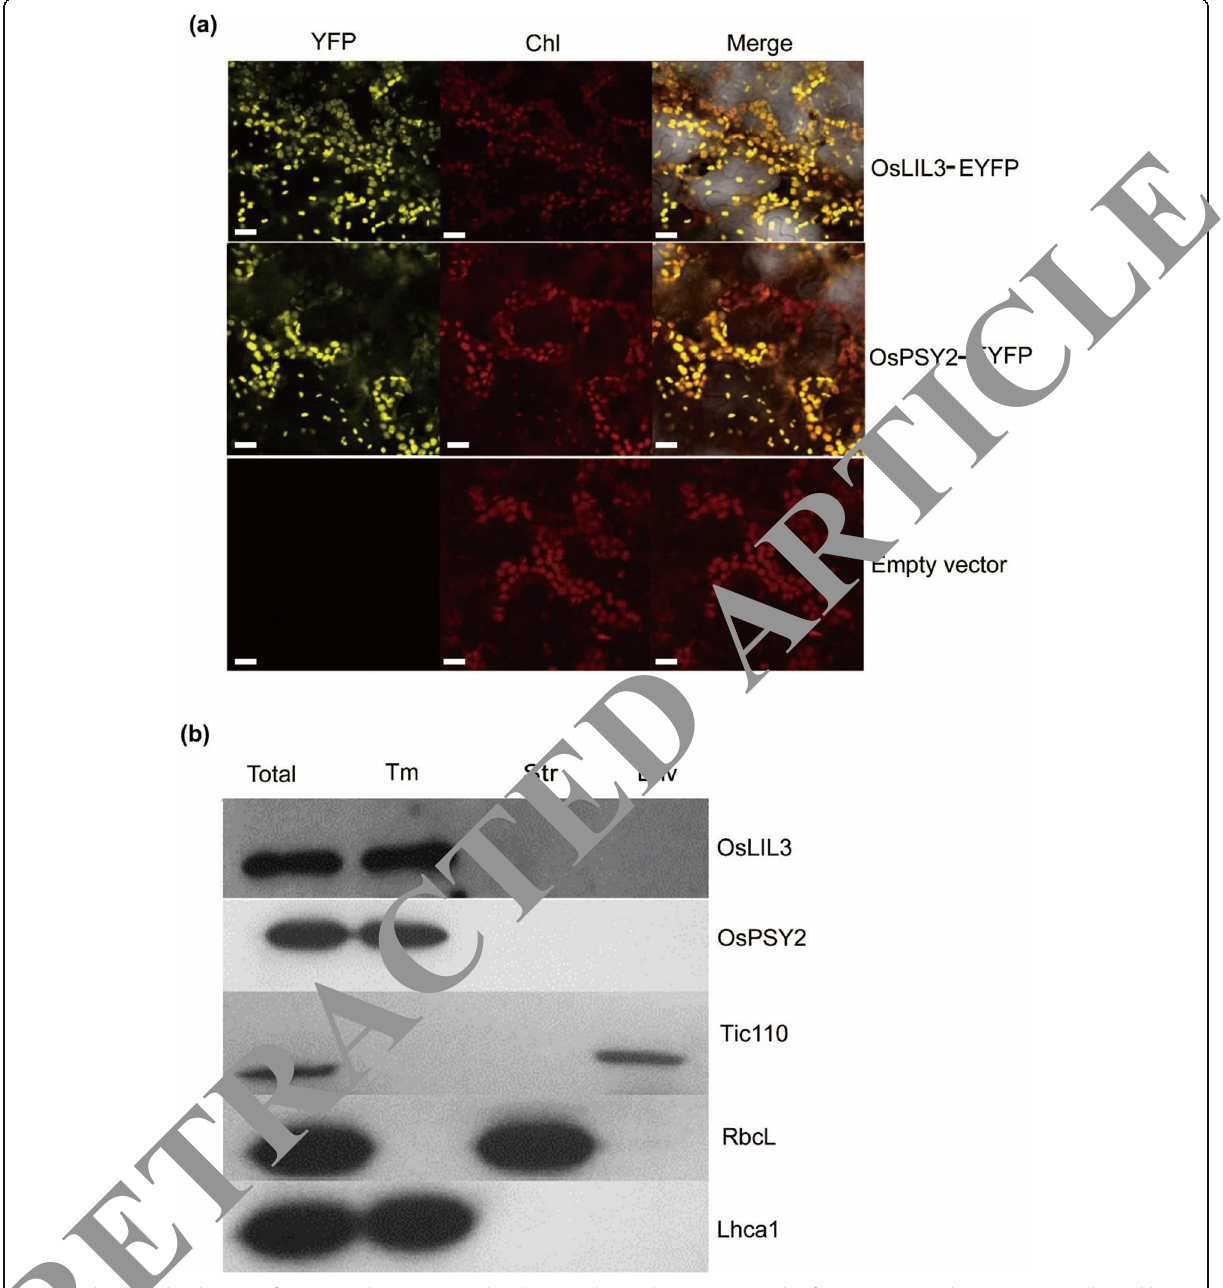
Fig. 5 Subcellular localization of OsLIL3 and OsPSY2 in N . benthamiana leavesFluorescent signals of OsLIL3-EYFP and OsPSY2-EYFP indicated by confocal microscopy. In both cases, chlorophyll autofluorescence (Chl) merged with yellow fluorescence signals, suggesting chloroplast localization. All bars = 10 μ m. The OsLIL3-EYFP and OsPSY2-EYFP signal were detected using the anti-GFP antibodies, both these two proteins located in the thylakoid membrane fraction but not stroma and envelope fractions compared to marker proteins (Tic110, envelope; RbcL, stroma; Lhca1, thylakoid membrane). Env, envelope membranes; Str, stroma; Tm, thylakoid